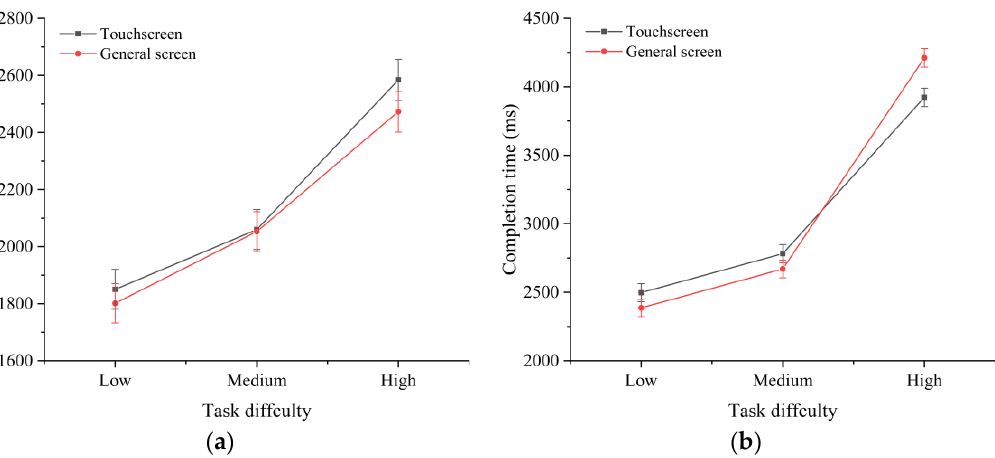
Figure 4. Interaction effects between the screen type and task difficulty ( a ) with and ( b ) without time-pressure conditions on the completion time.